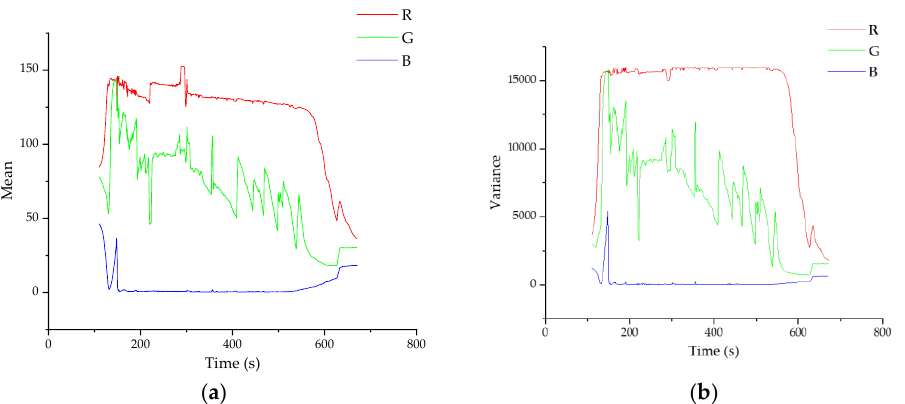
Figure 6. Changes in the mean value ( a ) and variance ( b ) of the image RGB during melting and crystallization.